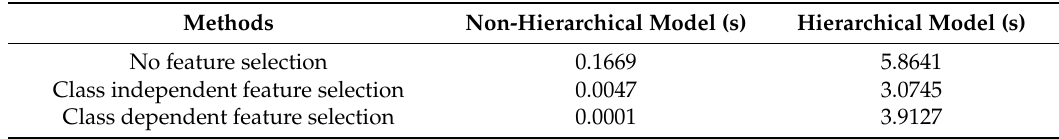
Table 10. Time cost comparison between hierarchical and non-hierarchical